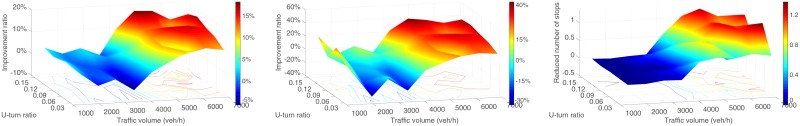
Sensitivity analysis of flow 1, EW through vehicles.The X axis is different traffic volumes, the Y axis is u-turn ratio and the Z axis is improvement ratio (Ratio = (MUTI-ESUL)/MUTI*100%) in a,b, and reduced times (Reduced times = MUTI-ESUL) in c. a. Travel time improvement ratio. b. Delay improvement ratio. c. Reduced number of stops.